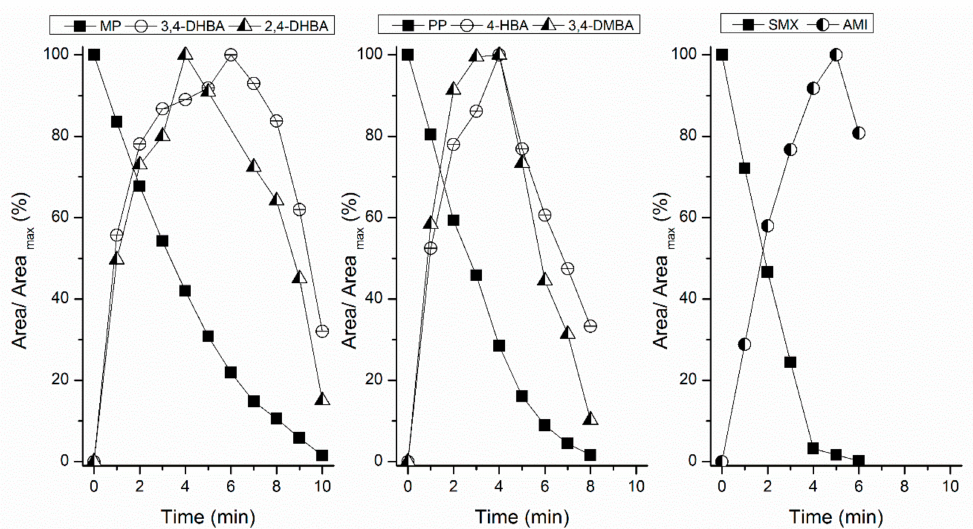
Figure 3. Normalized areas of MP, PP, and SMX and respective by-products obtained during ozonation. MP degradation promotes the production of 2,4-DHBA and 3,4-DHBA as main by- products, with the area maxima at 4 and 6 min, respectively (Figure 3). At the end of the reaction, these compounds persist in the solution while MP was almost completely removed. During PP degradation 4-HBA and 3,4-DMBA were quantified, the latter presenting a